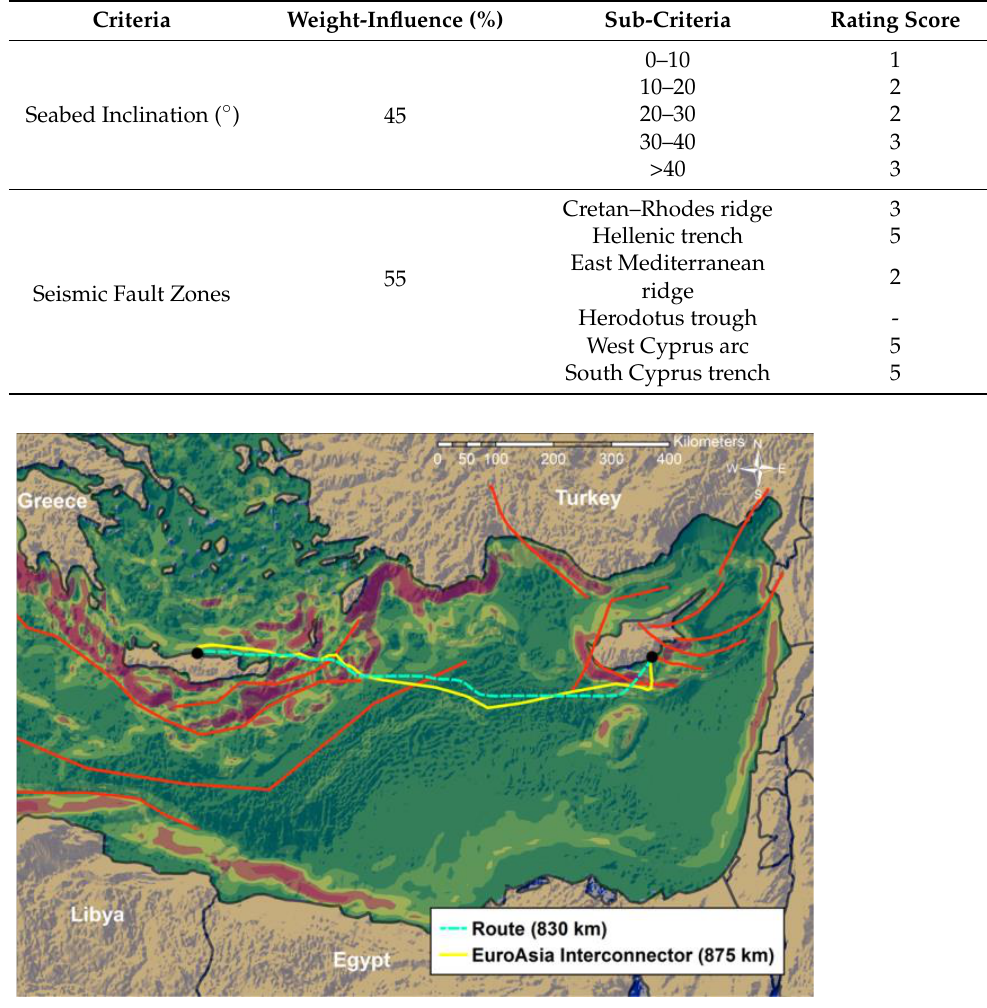
Figure 9. Verification of the routing analysis of the smart decision-support tool.